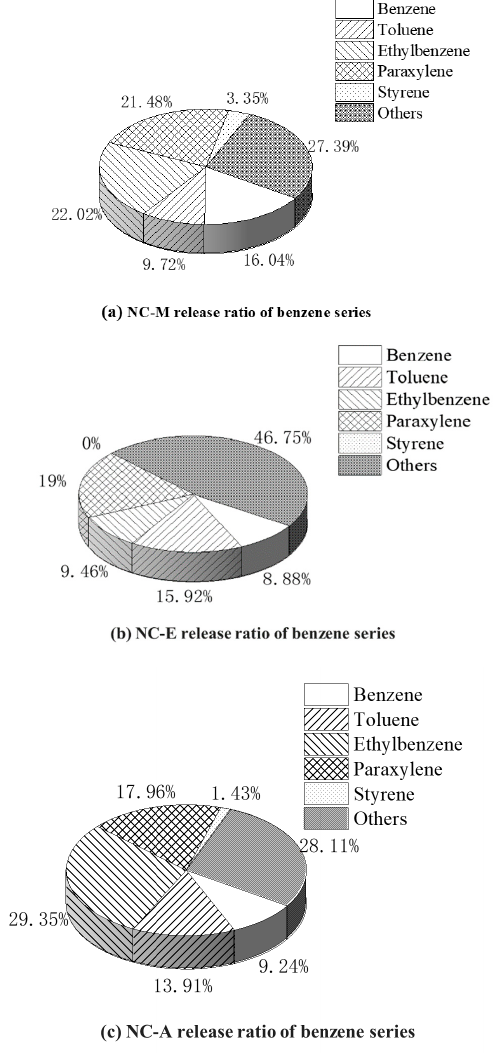
Figure 2. Proportion of Benzene Series released by the three kinds of NC-painted MDF.